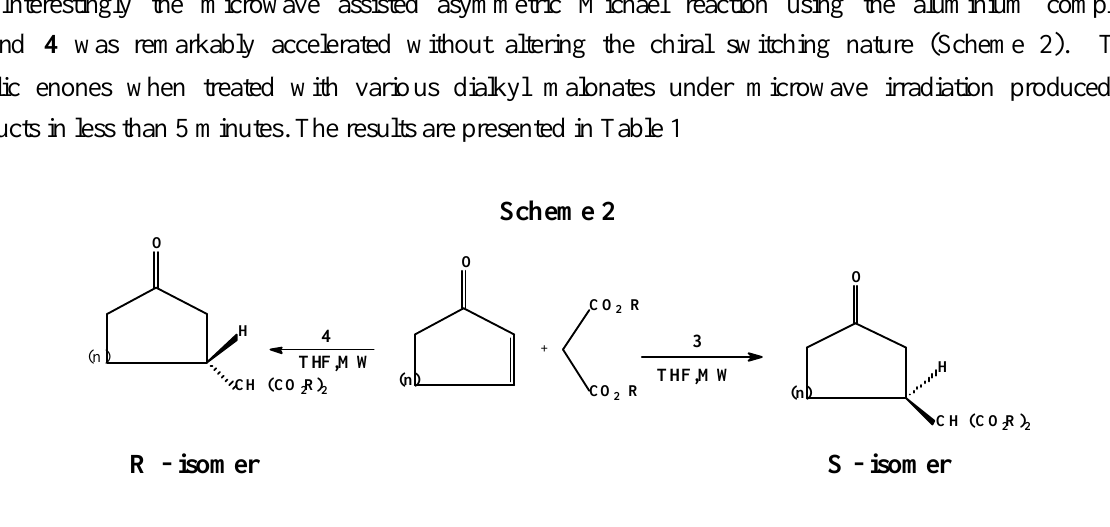
Table 1. Asymmetric Michael additions of cyclic enones with malonates under microwave irradiation.